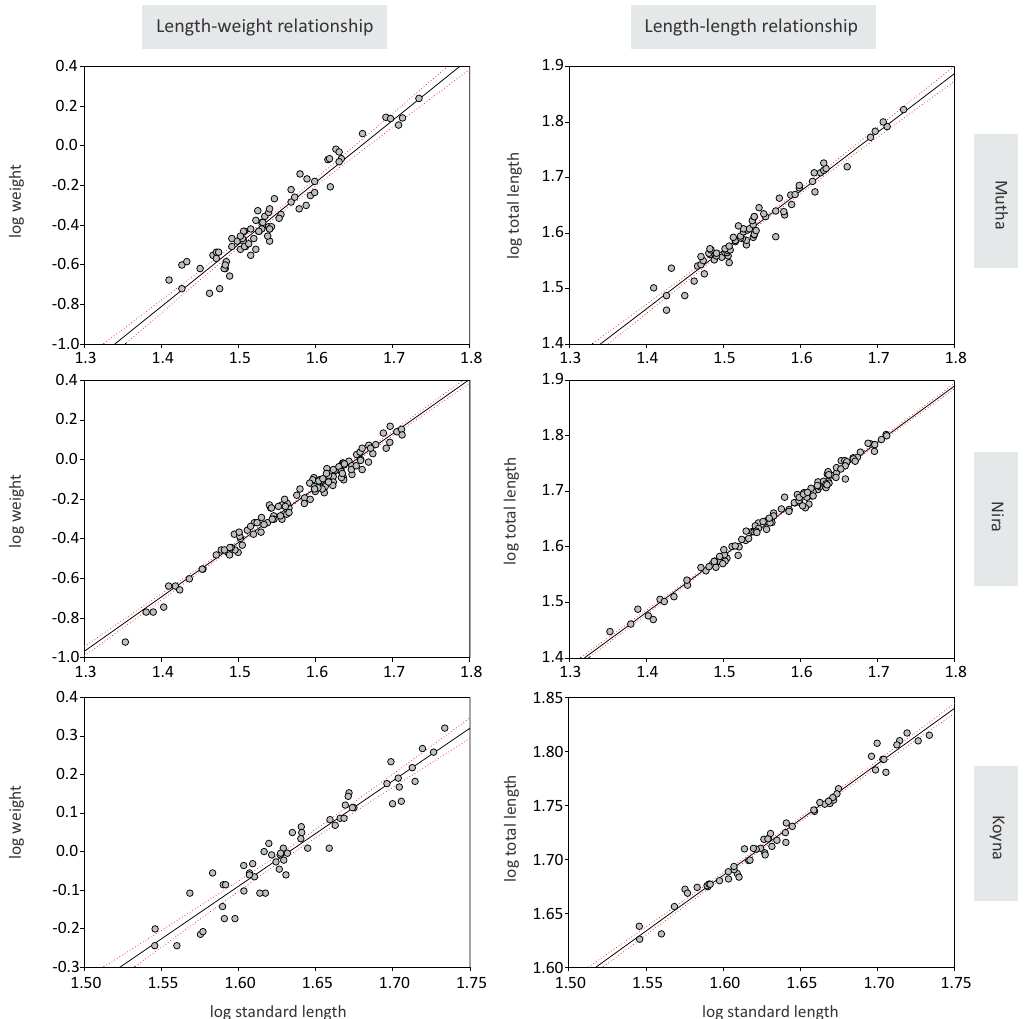
Appendix E. Scatter plots for Nemacheilus anguilla . Dashed lines are 95% confidence intervals for the regression